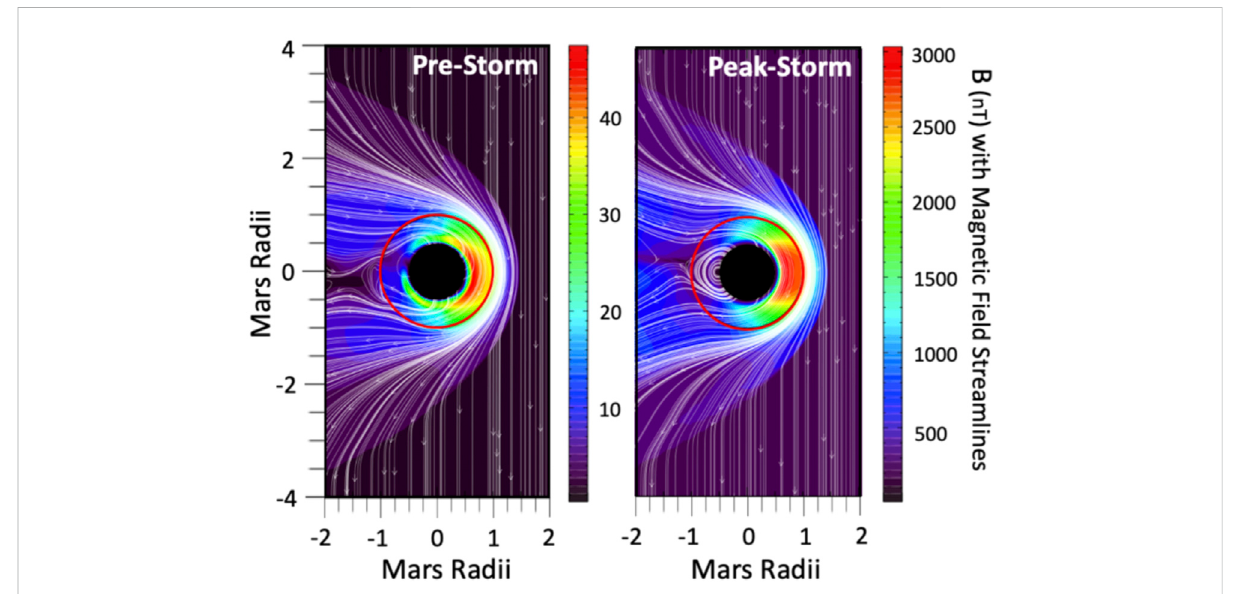
FIGURE 1 The modeled Martian responses to an extreme Carrington-type SW event before (left panel) and at the peak of the solar storm (right panel)